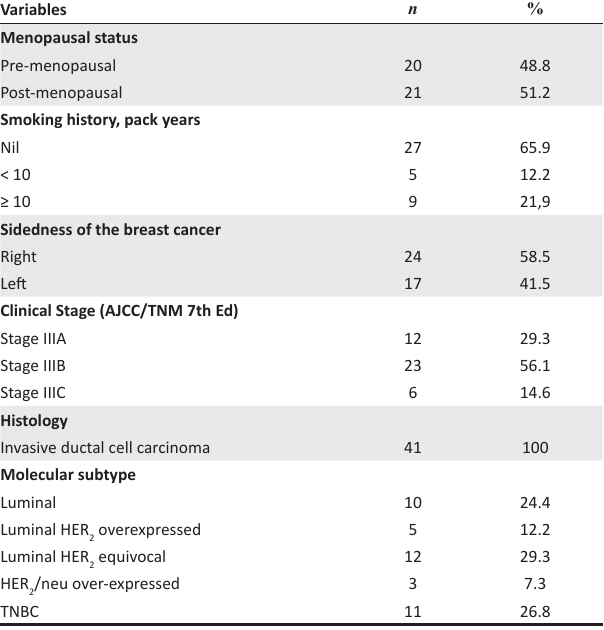
(Table 3): The bone scan detected bone metastases in